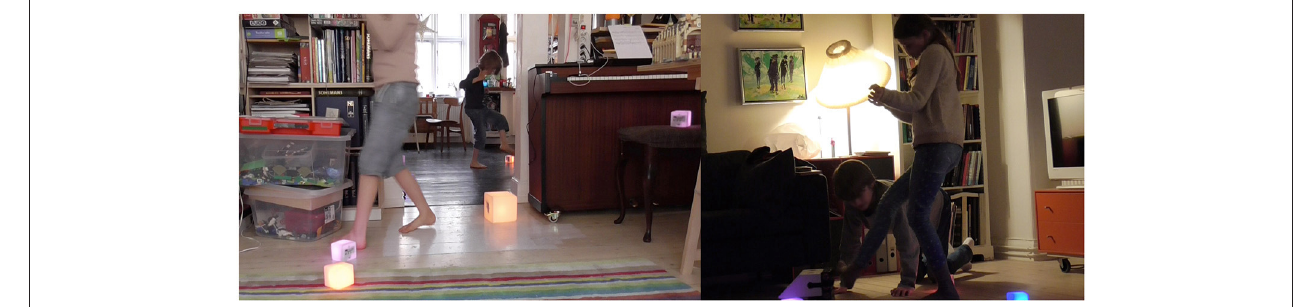
FIGURE 6 | Two examples of working together individually.